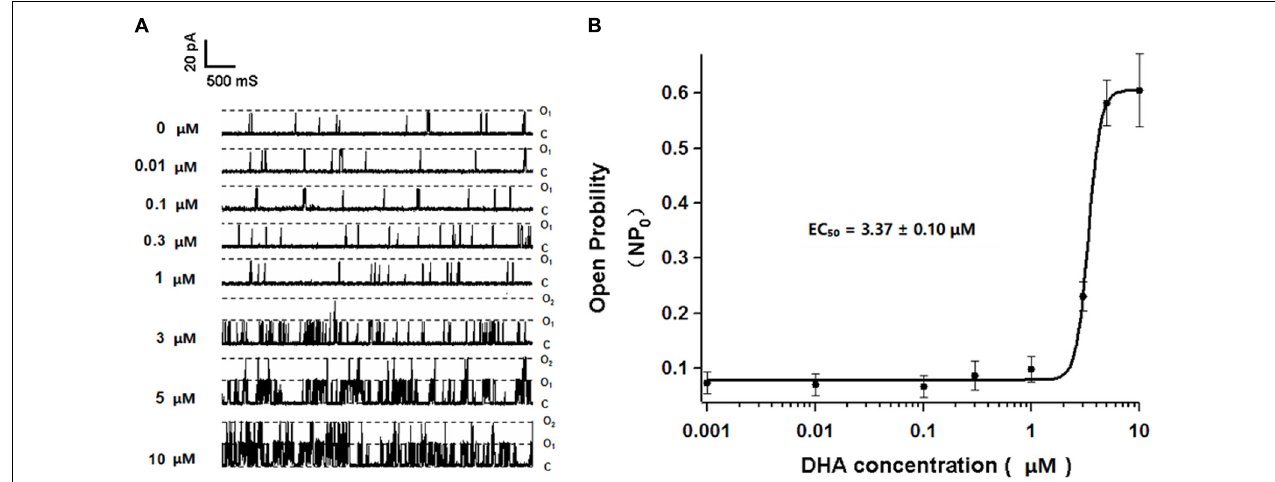
FIGURE 3 | Effects of different concentrations of DHA on single BK currents in rat CASMCs. (A) Representative current traces showing single BK currents at baseline and after exposure to 0.01, 0.1, 0.3, 1, 3, 5, and 10 µ M of DHA in rat CASMCs. (B) Concentration–response relationships showing the effects of DHA on BK channel activation, n = 5